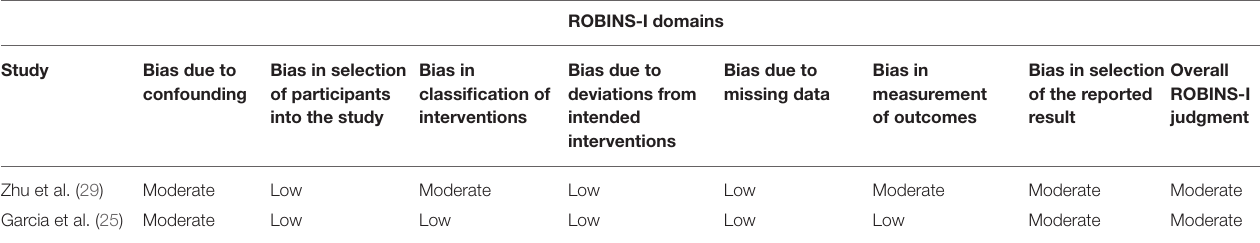
TABLE 2 | Quality assessment of non-randomized comparative studies using ROBINS-I